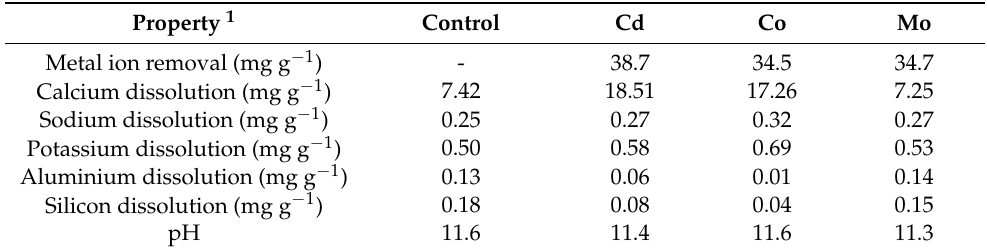
Table 2. Metal ion removal, pH of solution and dissolution of constituents of CCF after 3